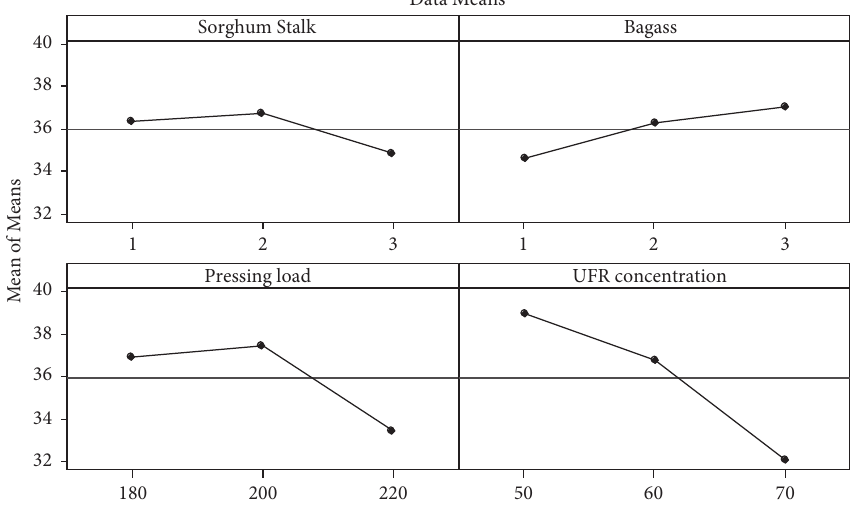
Figure 9: Main effect plot for means of moisture content (MC %). Table 13: Analysis of variance for water absorption, using adjusted SS for